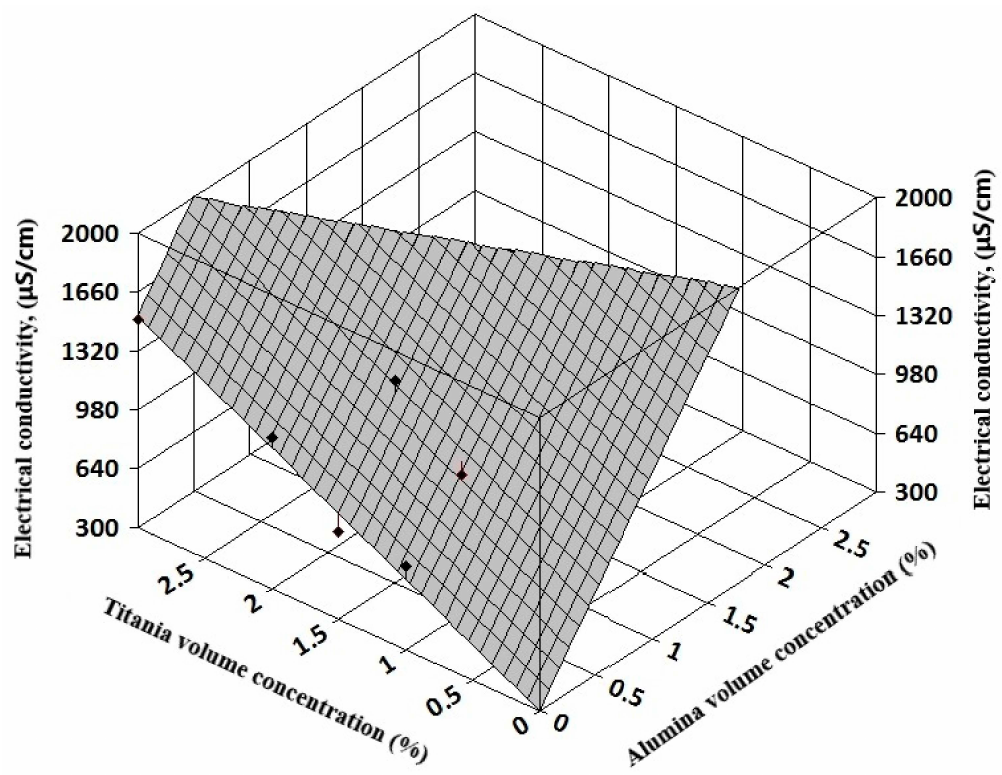
Figure 10. Three-dimensional analysis on alumina + titania hybrid